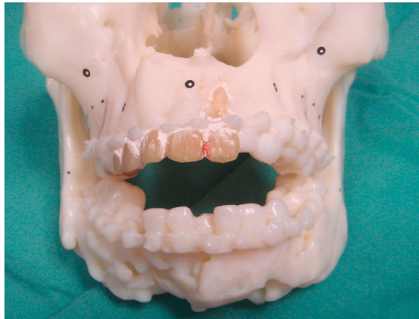
Figure 1: Acrylonitrile butadiene styrene (ABS) model showing comminuted mandible fracture with severe anterior open bite.